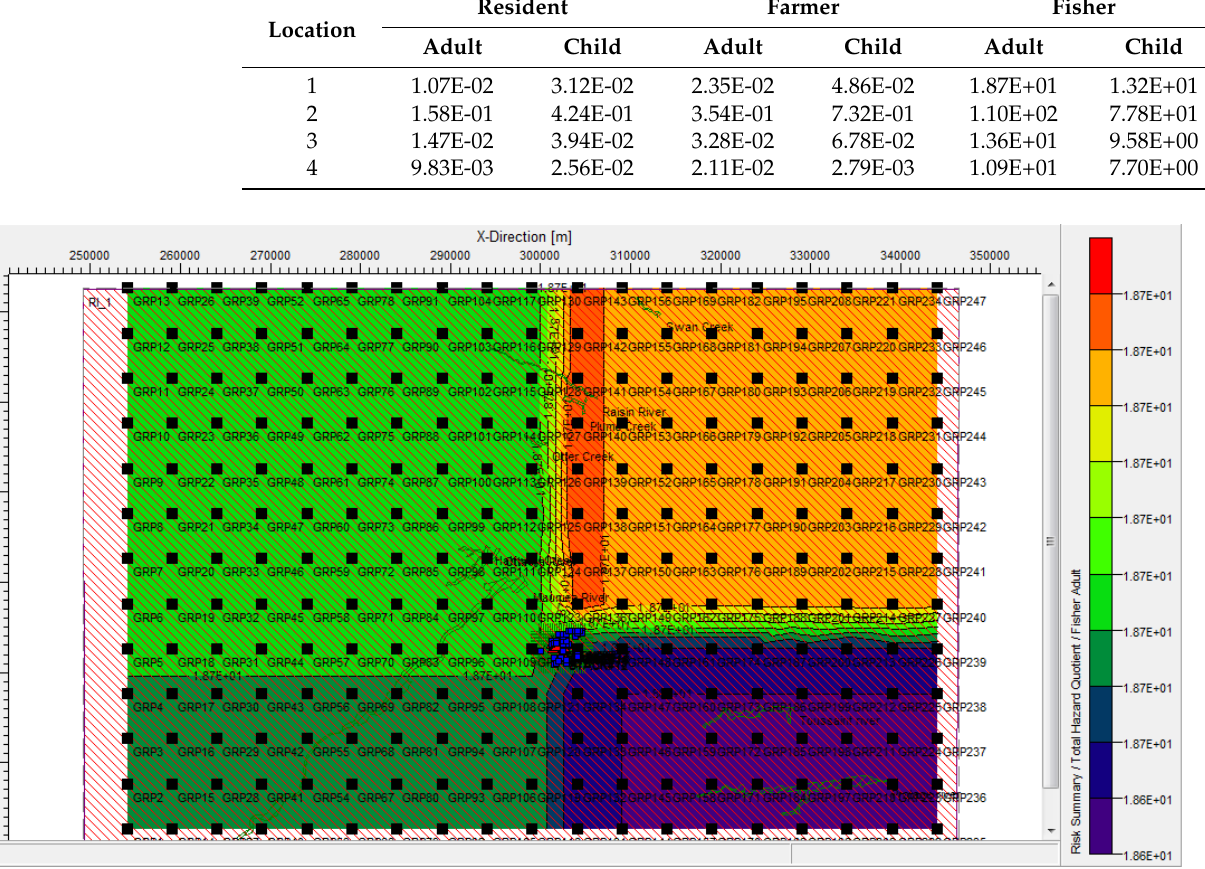
Figure 4. Contour plot of the total hazard quotient for location 1.